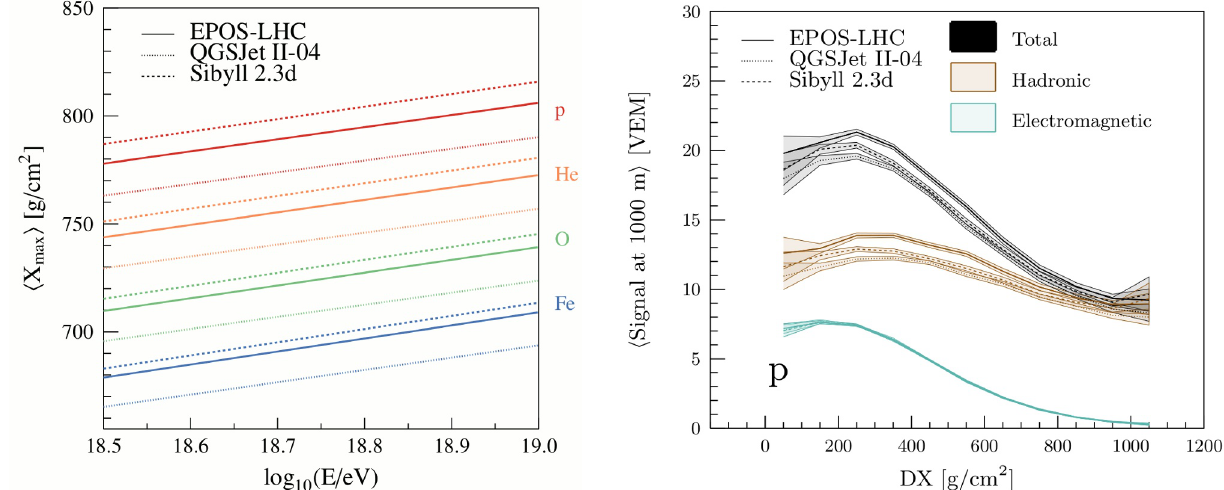
Figure 2: Left: Energy evolution of the mean of X max distribution predicted for three hadronic interaction models and four primary species. The model S ibyll 2.3d predicts on average by ≈ 7 g / cm 2 and ≈ 22 g / cm 2 deeper (cid:104) X max (cid:105) than the models E pos - lhc and Q gsjet II-04, respectively. Right: Decomposition of the total ground signal (black) into the hadronic (braun) and EM (turquoise) parts as predicted to depend on the distance of X max to the ground ( DX ). The ground signal at 1000 m from the shower core is simulated for responses at the Pierre Auger Observatory to showers generated using three hadronic interaction models in case of protons of energies 10 18 . 5 − 10 19 . 0